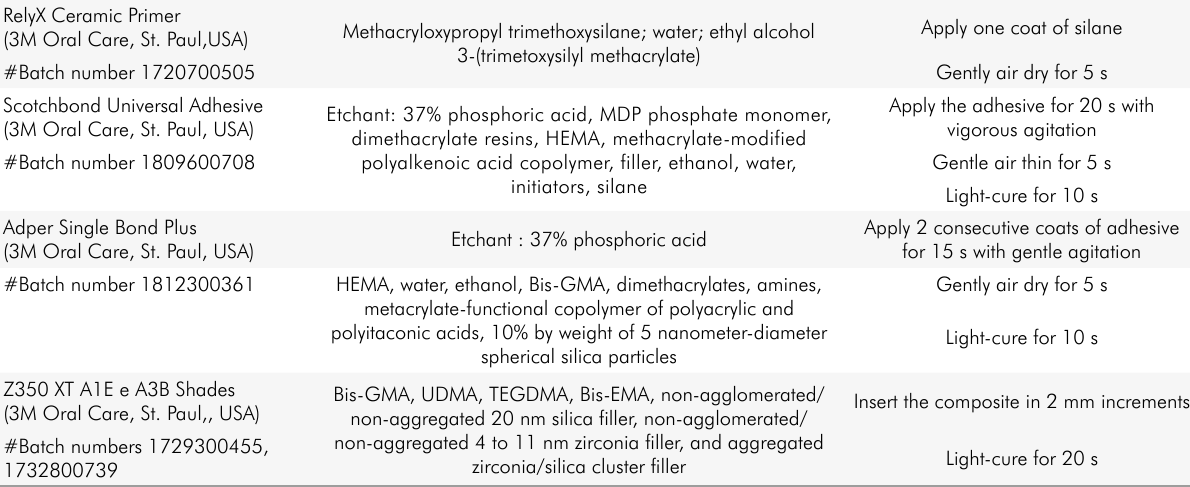
Table 1. Composition and application mode of the materials tested. RelyX Ceramic Primer (3M Oral Care, St.